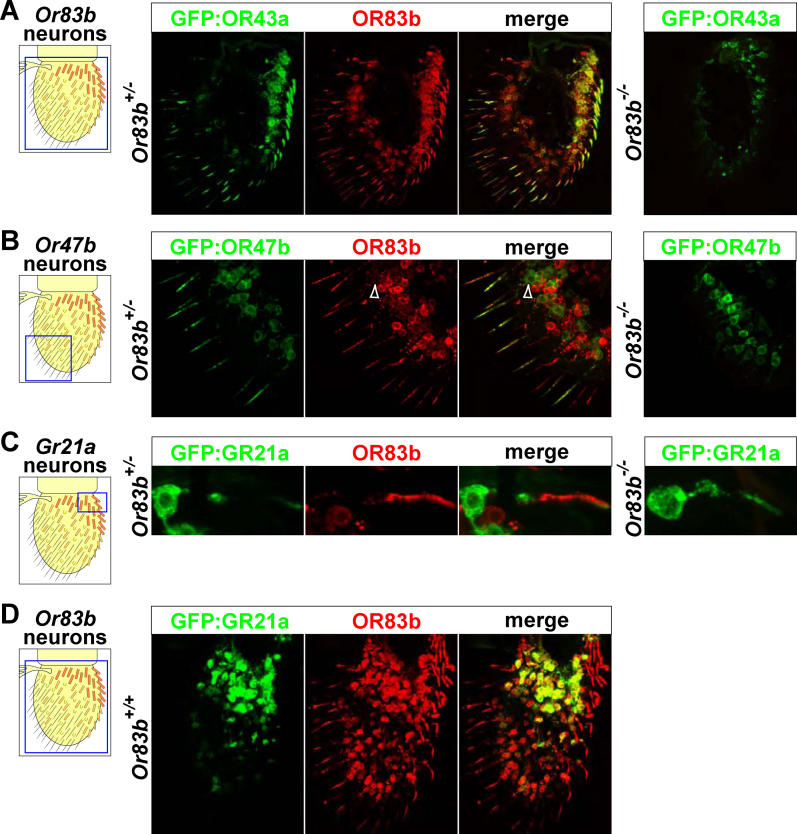
Spatial Requirements for OR83b in OR Localization(A) Immunostaining of GFP:OR43a (α-GFP, green) expressed in all Or83b neurons and OR83b (red) in antennal sections of control heterozygous (Or83b-Gal4/UAS-GFP:Or43a;Or83b1/+, left panels) and homozygous (Or83b-Gal4/UAS-GFP:Or43a;Or83b1/Or83b2, right panel) Or83b null-mutant animals.(B) Immunostaining for GFP:OR47b (α-GFP, green) expressed in Or47b neurons and OR83b (red) in antennal sections of control heterozygous (Or47b-Gal4/UAS-GFP:Or47b;Or83b1/+, left panels) and homozygous (Or47b-Gal4/UAS-GFP:Or47b;Or83b1/Or83b2, right panel) Or83b null-mutant animals. Arrowheads illustrate low level of OR83b expression in Or47b neurons.(C) Immunostaining for GFP:GR21a (α-GFP, green) expressed in Gr21a neurons and OR83b (red) in antennal sections of control heterozygous (Gr21a-Gal4/UAS-GFP:Gr21a;Or83b1/+, left panel) and homozygous (Gr21a-Gal4/UAS-GFP:Gr21a;Or83b1/Or83b2, right panel) Or83b null-mutant animals. The OR83b signal in this sensillum reflects expression in the non-Gr21a-expressing neurons ab1A, ab1B, and ab1D, whose olfactory responses are Or83b-dependent [22,32].(D) Immunostaining for GFP:GR21a (α-GFP, green) expressed in all Or83b neurons and OR83b (red) in antennal sections of wild-type animals (Or83b-Gal4/+;UAS-GFP:Gr21a/+).